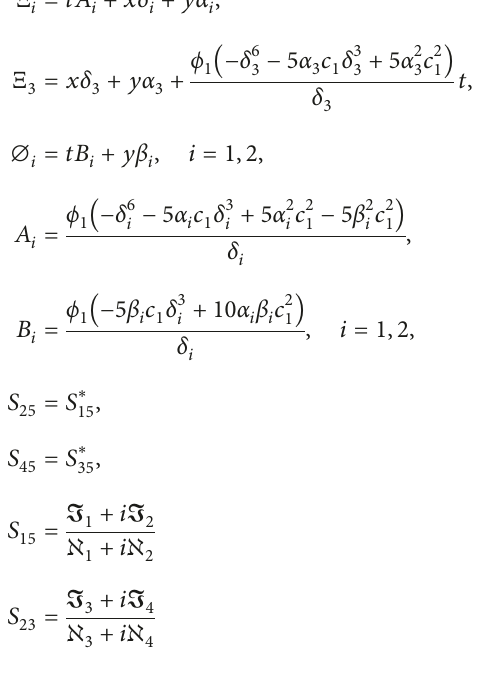
( t ) � 1 , ϕ ( t ) � cos ( t + 3 ) , c 1 9